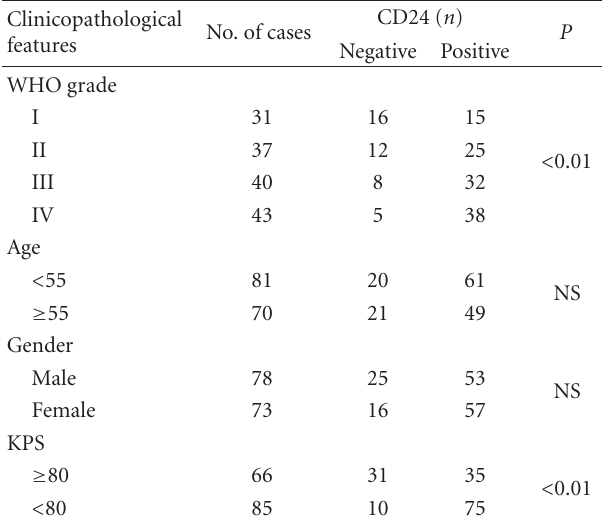
Table 1: CD24 expression in human glioma tissues with di ff erent clinical-pathological features.